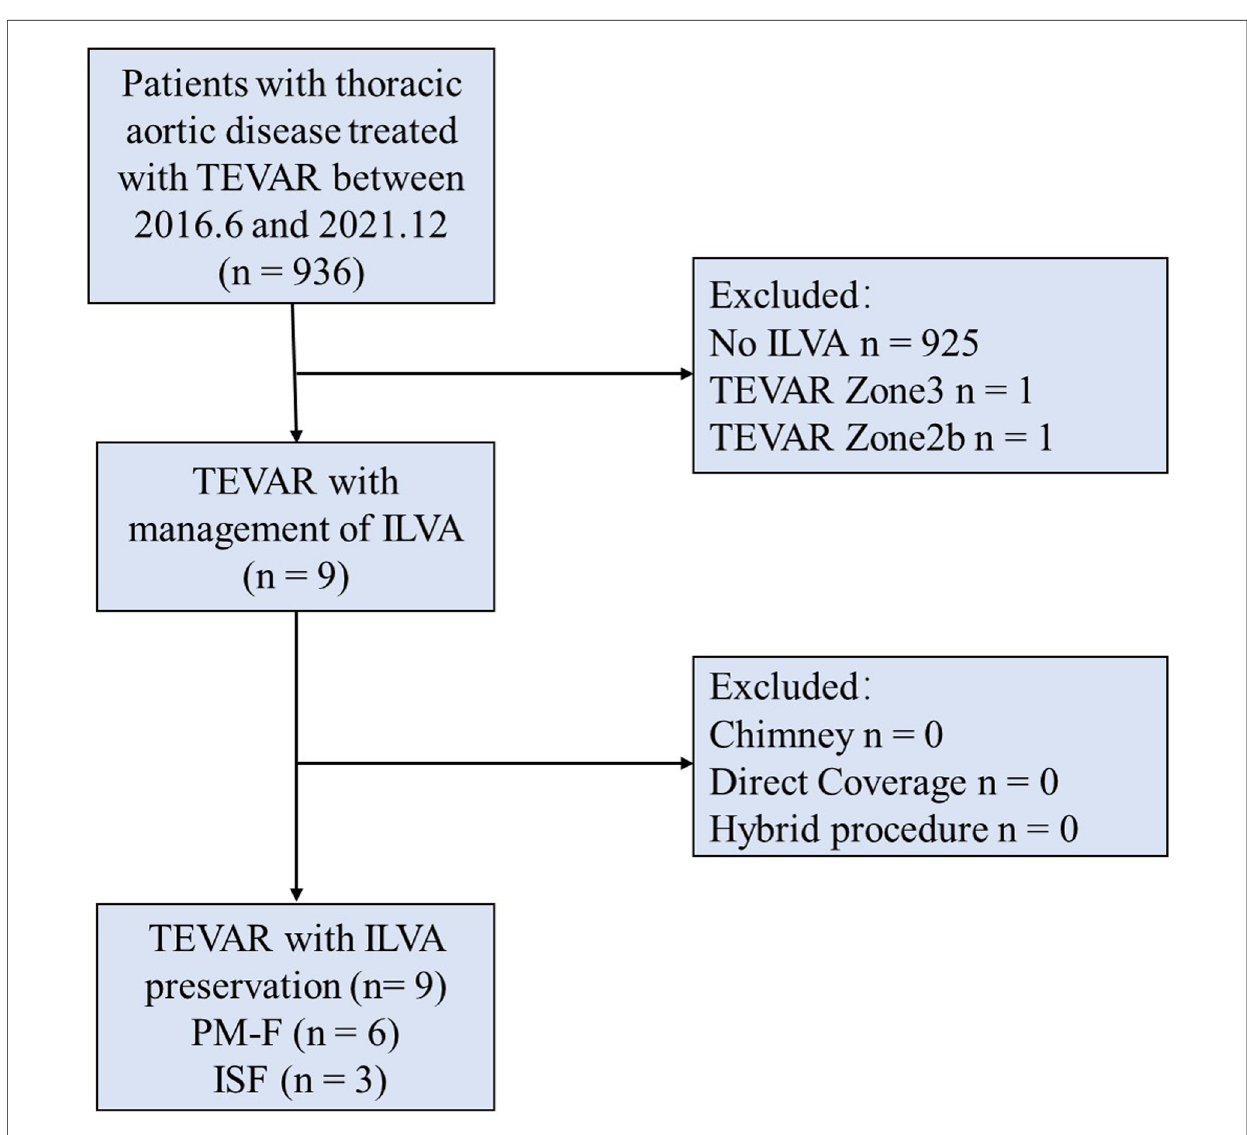
FIGURE 1 Consort diagram of thoracic aortic repairs (2017.6 – 2021.12; n =936). TEVAR, thoracic endovascular aortic repair; ILVA, isolated left vertebral artery; PM-F, physician modi fi ed-fenestration; ISF, in situ